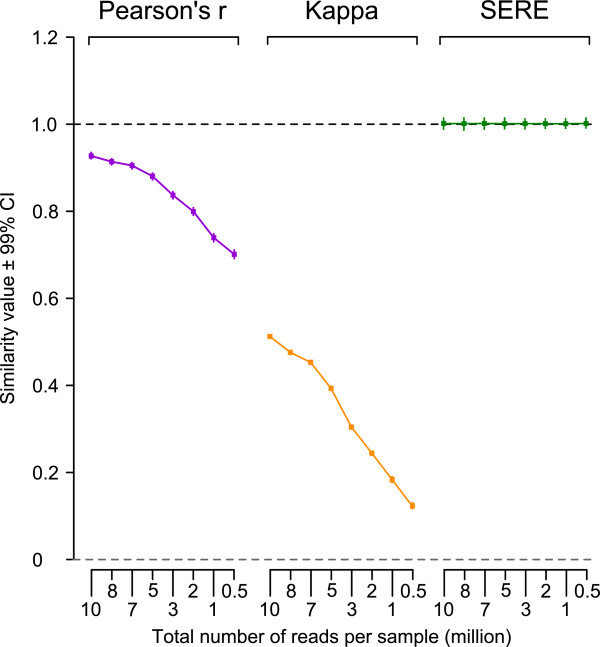
Total read count (sample size) dependence of candidate statistics comparing perfect replicate RNA-Seq datasets. The Simple Error Ratio Estimate (SERE) was 1 when two replicate RNA-Seq datasets of different sizes were compared. Variation of SERE for repeat computations from independent replicate dataset pairs for each total read count demonstrated a stable 99% confidence interval (CI) of approximately +/- 0.01. The Pearson correlation coefficient fell as read counts decreased. Kappa also strongly depended on the total read count. All computations were performed on 200 model RNA-Seq datasets obtained by drawing reads randomly from a universal read set (described in Methods).